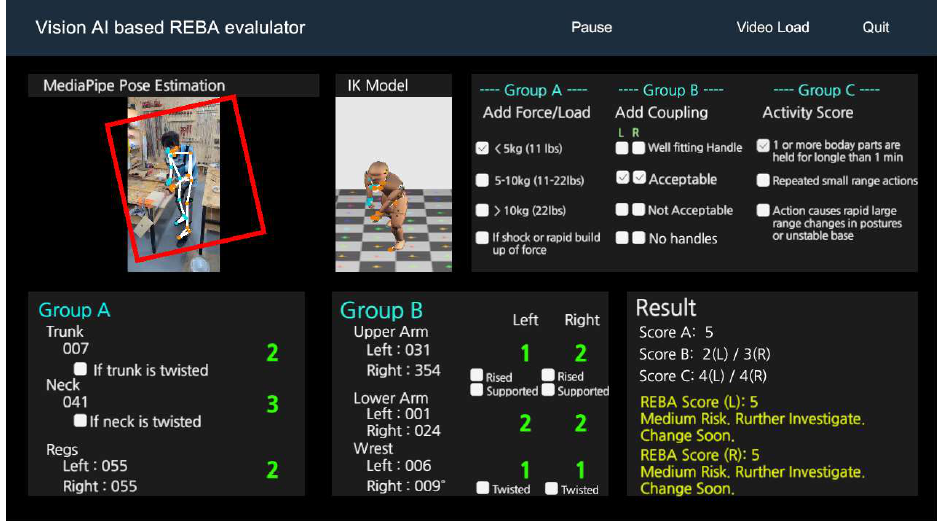
Figure 31. Evaluation of saw working